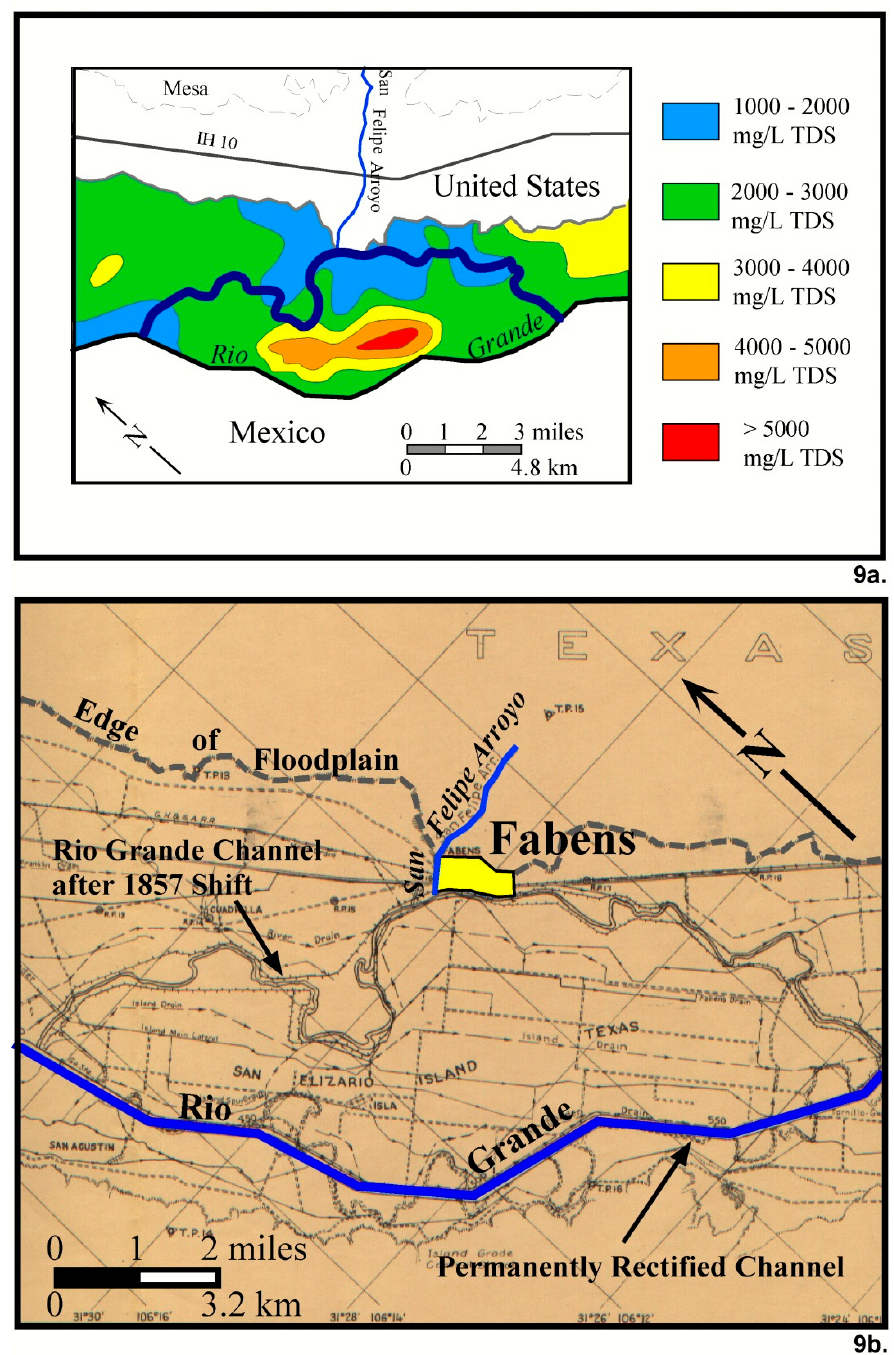
Figure 9. Comparison of the Rio Grande Aquifer salinity map of Alvarez and Buckner [12] with the historic trajectory of the pre-dam Rio Grande, prior to channel rectification completion in 1938. The old channel is shown near Fabens, Texas in the historic map of the irrigation district [36]. The dilute groundwater water presented in Alvarez and Buckner [12], blue color) and the sweet water in deeper wells in the Fabens/Tornillo area appears to have been sourced from the pre-dam Rio Grande and not from San Felipe Arroyo, based on environmental isotopes and geological framework ( a ). The Rio Grande flowed near Fabens for several decades prior to channel rectification ( b ).